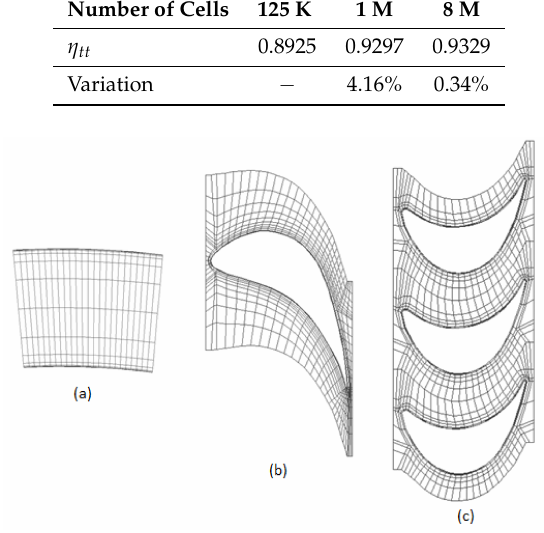
Figure 4. Mesh distribution for 125 k cells. ( a ) radial distribution ( b ) stator vane distribution ( c ) rotor vane distribution.